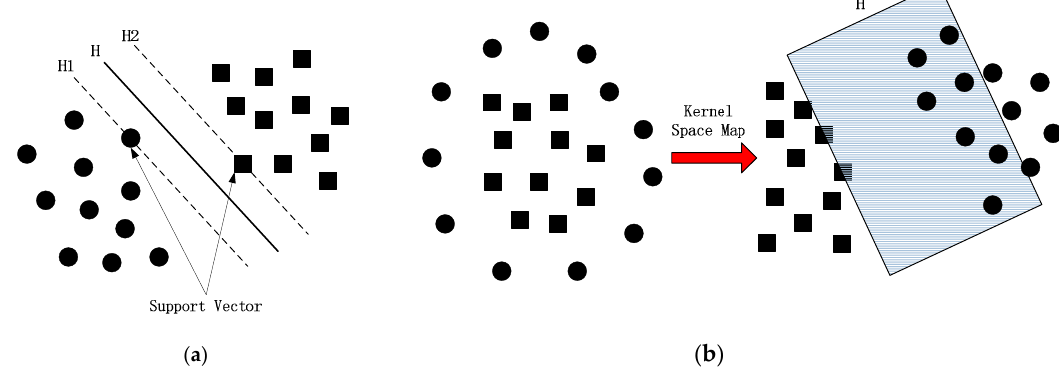
Figure 1. Linear ( a ) and non-linear ( b ) classification of support vector machine (SVM).